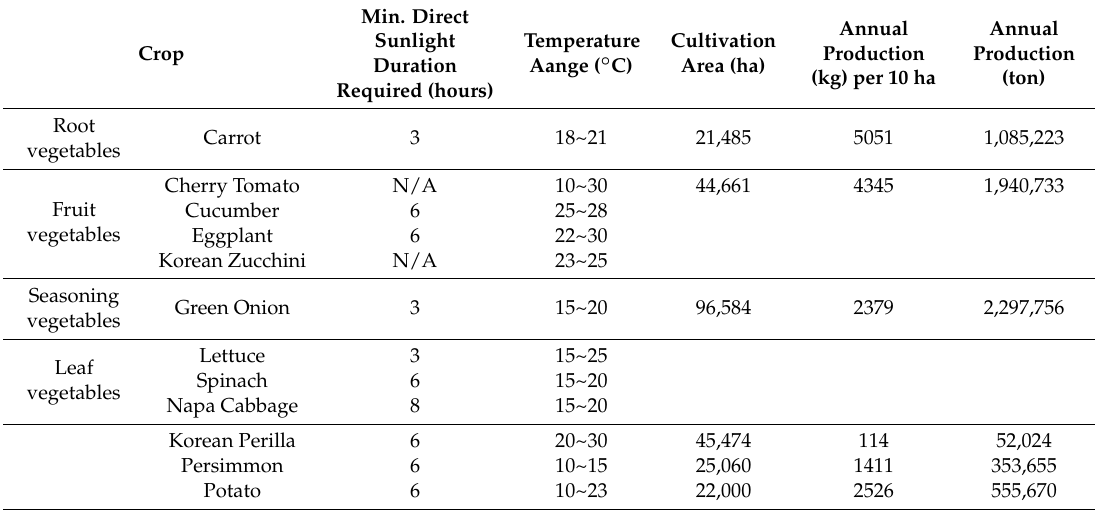
Table 1. Twelve most common crops in South Korea and their growing conditions. Min. Direct Crop